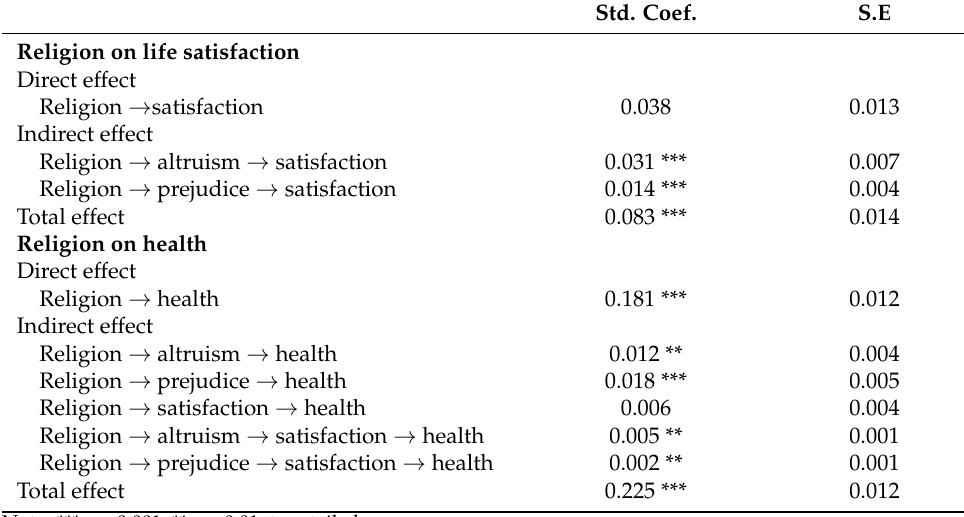
Table 3. The Decomposition of the Effects of Religiosity on Life Satisfaction and Health.